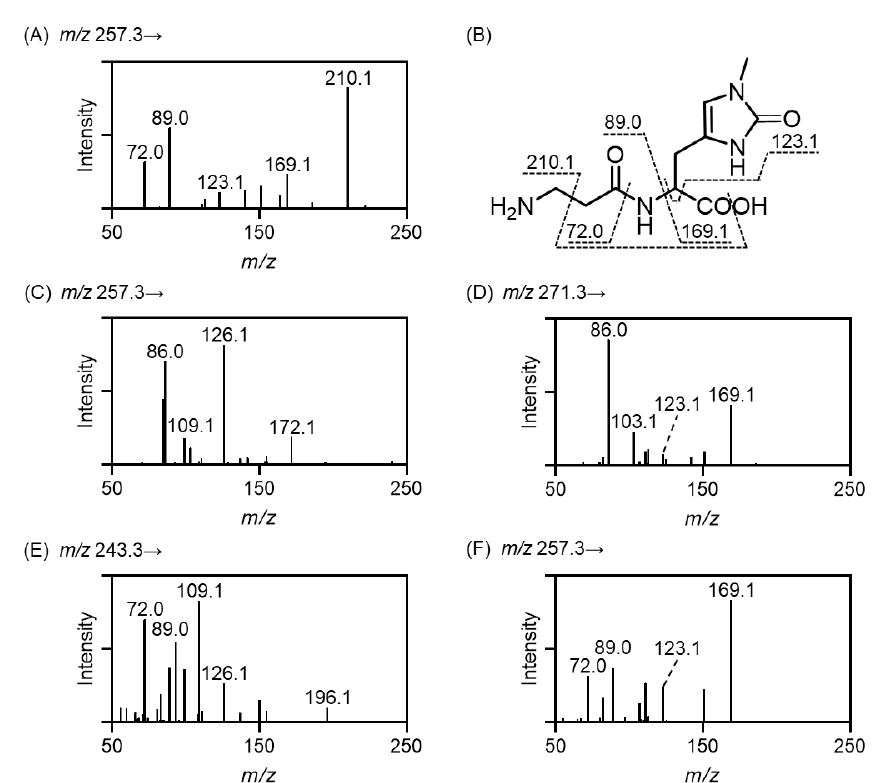
Figure 2. MS/MS spectra of 2-oxo-IDPs. 2-Oxo-IDPs were prepared by the copper/ascorbate oxidation system and subjected to HPLC-ESI-MS/MS. MS/MS spectra of 2-oxo-balenine ( A ), 2-oxo-homocarnosine ( C ), 2-oxo-homoanserine ( D ), 2-oxo-carnosine ( E ), and 2-oxo-anserine ( F ) are shown. The assignment of the product ions of 2-oxo-balenine were conducted as shown in ( B ). Table 2. MRM parameters for 2-oxo-IDPs and stable isotope-labeled 2-oxo-IDPs. Analyte Precursor Ion ( m/z